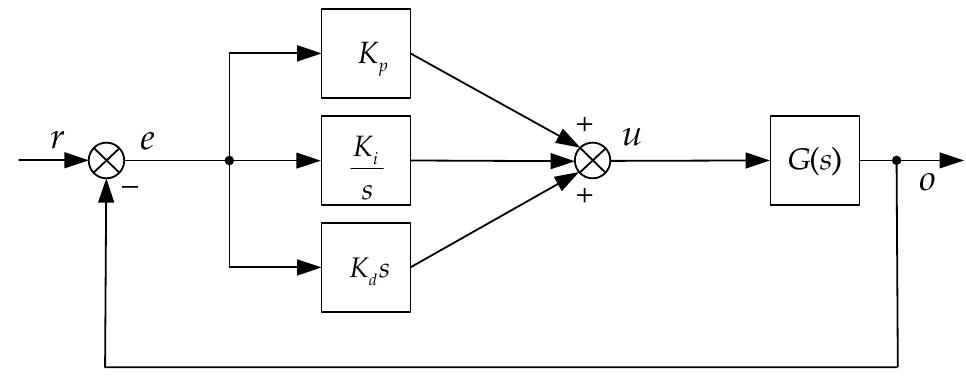
Figure 3. Structure diagram of PID controller.